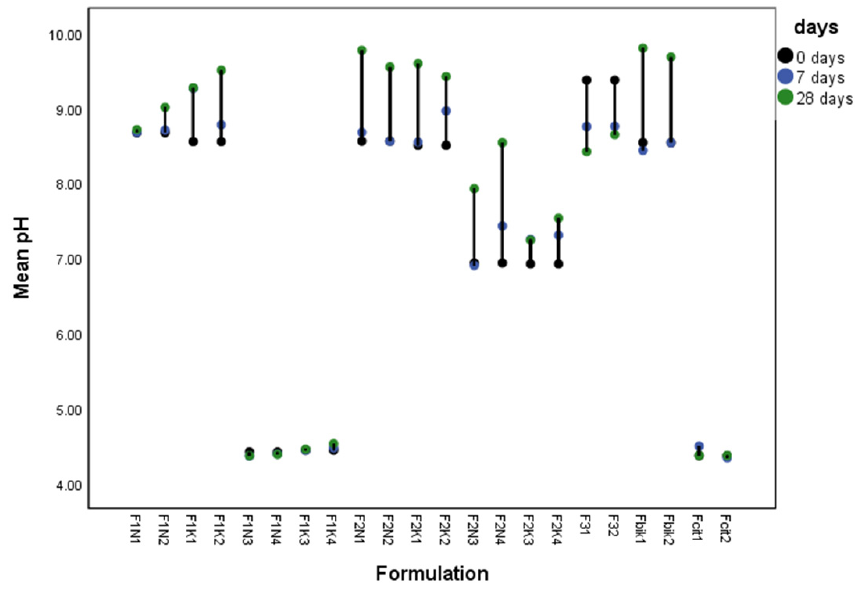
Figure 1. Bar chart of pH values in all investigated formulations (with and without preservative and refrigerated and those kept at room temperature) with addition of citrate buffer (0.16 M) and bicarbonate solution (8.4%) at 0, 7 and 28 days.